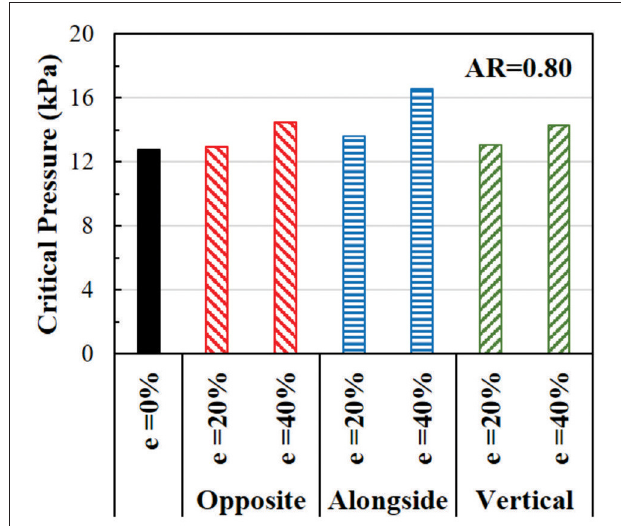
FIGURE 10 | Comparison of the critical buckling pressures of arteries with an eccentric elliptical cross-section with initial lumen AR = 0.80. The critical pressure of arteries with lumen eccentric alongside (same), opposite, and vertical to the direction of deflection are also compared.